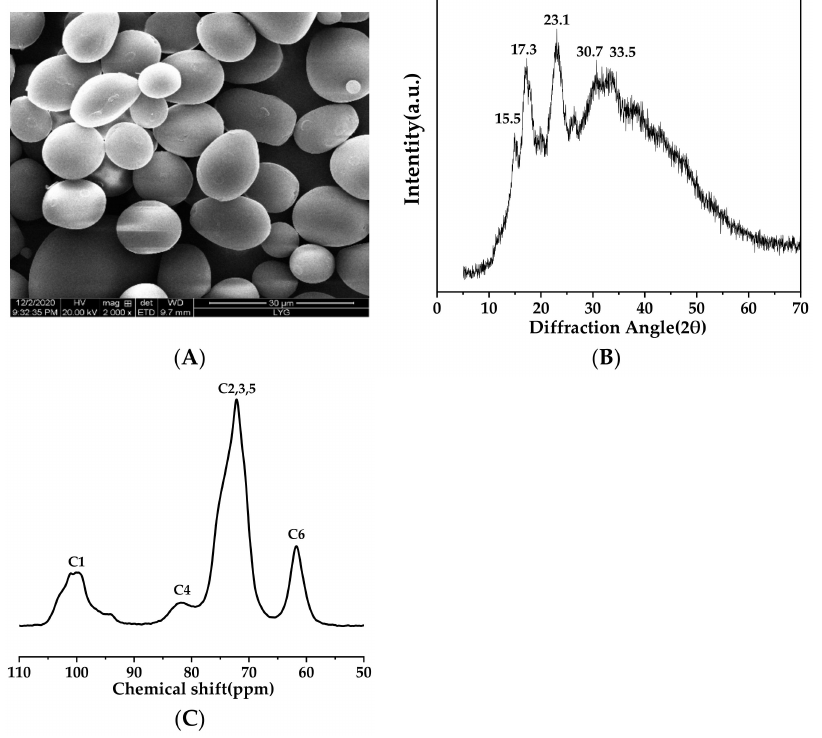
Figure 2. ( A ) SEM micrograph of arrowroot starch (magnification was 2000); ( B ) X-ray diffraction pattern of arrowroot starch; and ( C ) 13 C Solid-State NMR of arrowroot starch